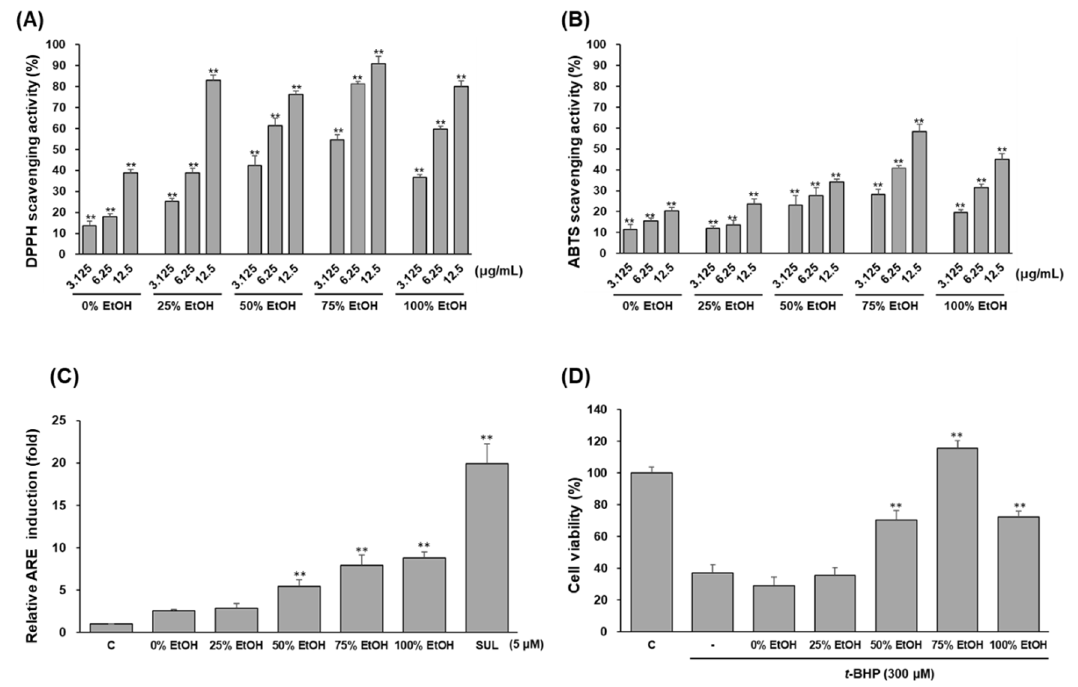
Figure 8. Effects of ethanol-water composition on the DPPH ( A ), ABTS ( B ) radical scavenging, ARE- luciferase induction ( C ), and HepG2 cell protective ( D ) activity. Data are presented as the mean ± S.D. ( n = 3). ** p < 0.01 (compared with the vehicle-treated control). Table 1. Contents of compounds 1 – 12 in extract obtained from mixtures of ethanol and